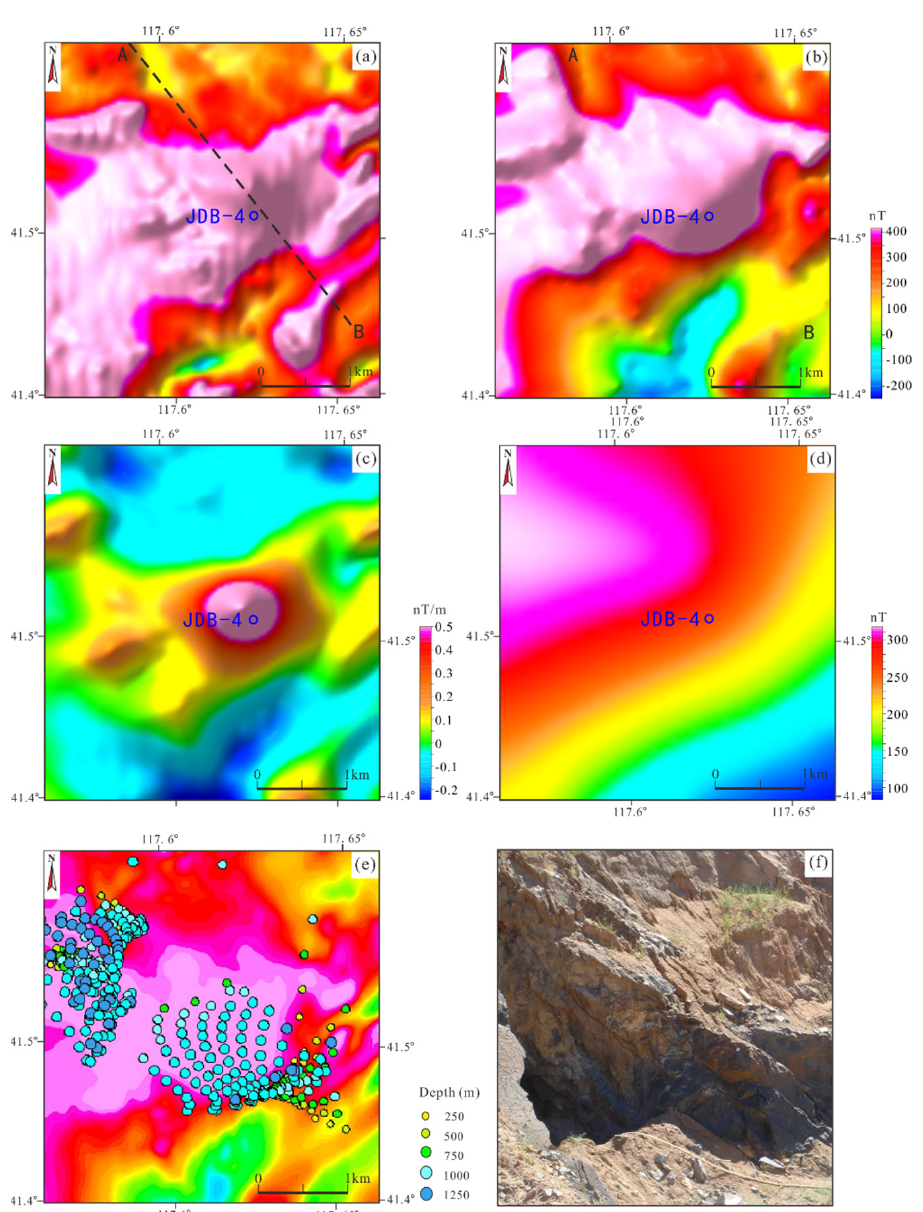
Figure 7. Aeromagnetic anomaly JDB-4 and its corresponding magnetite deposit: ( a ) Aeromagnetic data ∆ T, ( b ) reduction to the pole of aeromagnetic data ∆ T, ( c ) the first vertical derivative of reduction to the pole of aeromagnetic data ∆ T, ( d ) reduction to the pole of aeromagnetic anomaly (upwards extending 3 km), ( e ) depth by Euler deconvolution, ( f ) photograph of iron deposit mined. A–B are the locations of the section shown in Figure 8.